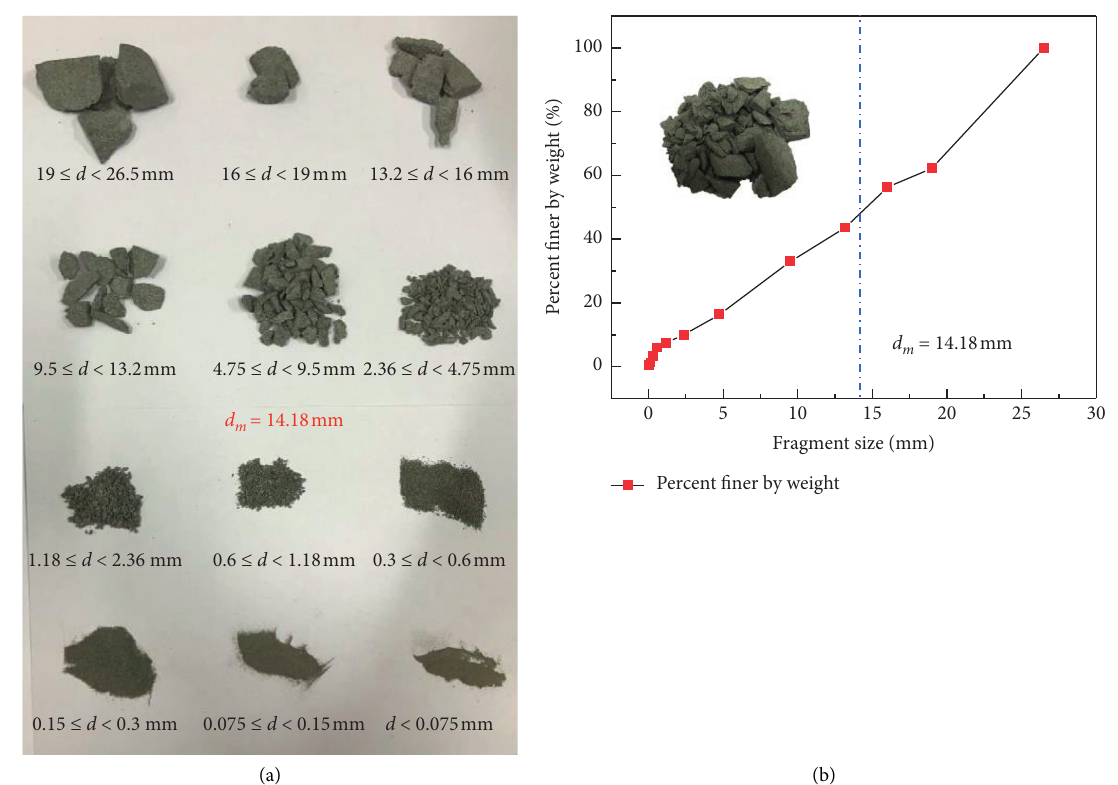
Figure 15: Fragment distribution of gray sandstone at an impact speed of 11.208m/s: (a) fragments with various sizes and (b) fragment size distribution.